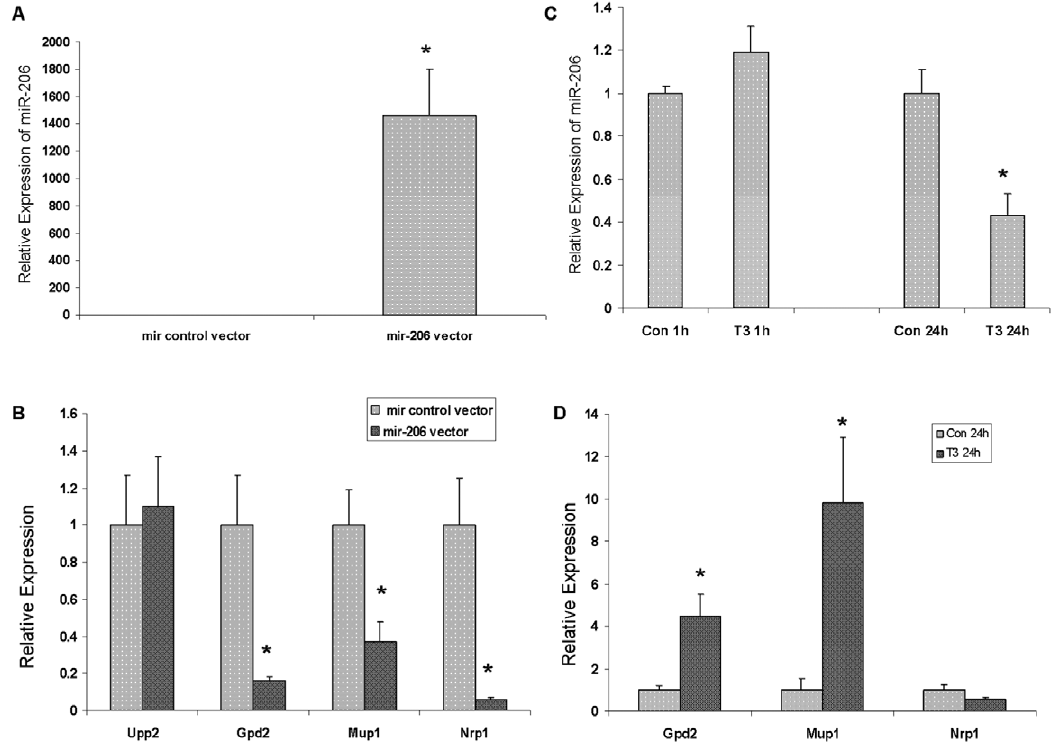
Figure 4. Identification of the target genes of miR-206 that are regulated by TH. A. Levels of miR-206 in AML 12 cells stably transfected to ectopically express miR-206. AML12 cells were transfected with pEGP-mmu-mir-206 expression vector or pEGP-mir null control vector and selected with puromycin and green florescence protein by microscopy. The expression of miR-206 was examined with the Taqman miRNA Assay (n=5). B. The expression of genes that are putative targets of miR-206 in the two cell types shown in figure 4A was examined with RT-PCR (n=3). C. The effects of TH on the expression of miR-206 in the transfected cells. The miR-206 transfected cells were treated with 10 nm T3 for 24 hours. MiR-206 expression was analyzed with Taqman miRNA Assay (n=3). D. The effect of TH on the expression of the miR-206 target genes in the transfected cells. The miR- 206 transfected cells were treated with 10 nm T3 for 24 hours. The expression of target genes was examined with RT-PCR (n=3). Data are presented as mean 6 SE. A two-tailed Student’s t-test was used to calculate significance. * indicates p ,